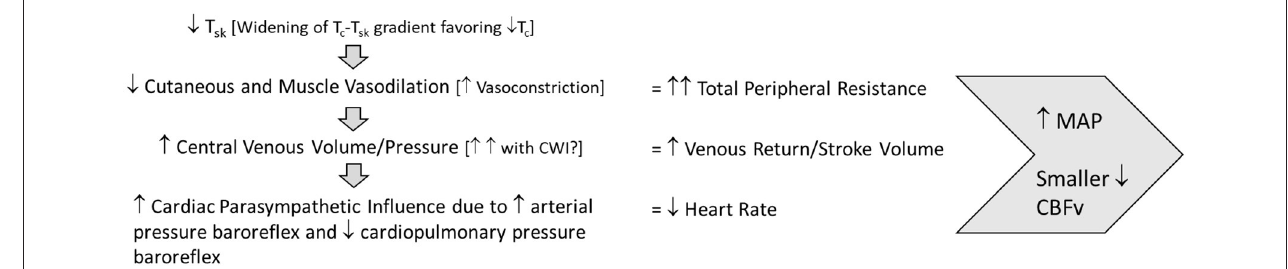
FIGURE 1 | Post-exercise cooling cardiovascular adjustments to maintain orthostatic tolerance. T sk , skin temperature; T c , core temperature; MAP, mean arterial pressure; CBF v , cerebral blood flow